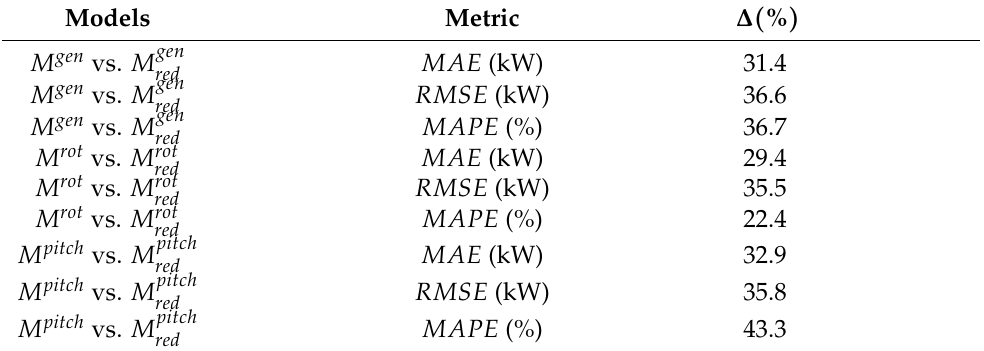
Table 6. Average percentage reduction in error metrics for the full models with respect to the reduced models: WF1.